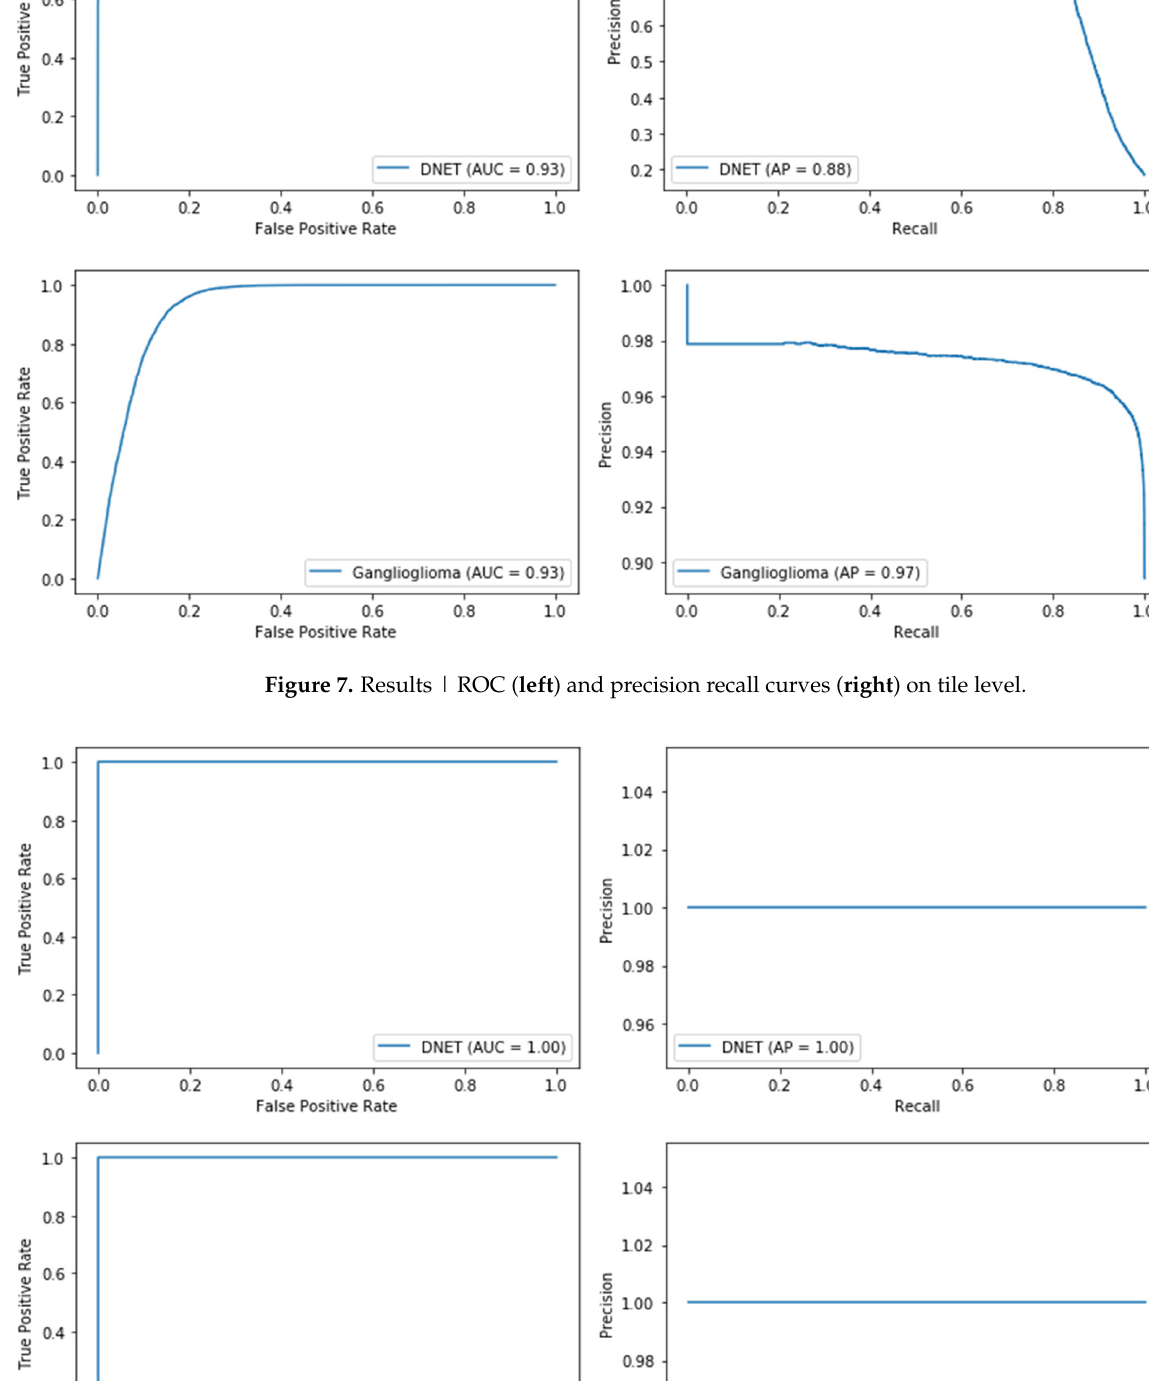
Figure 9. Results | Calibration plot. 3.2. Use Case 2: Pituitary Adenoma Classifier